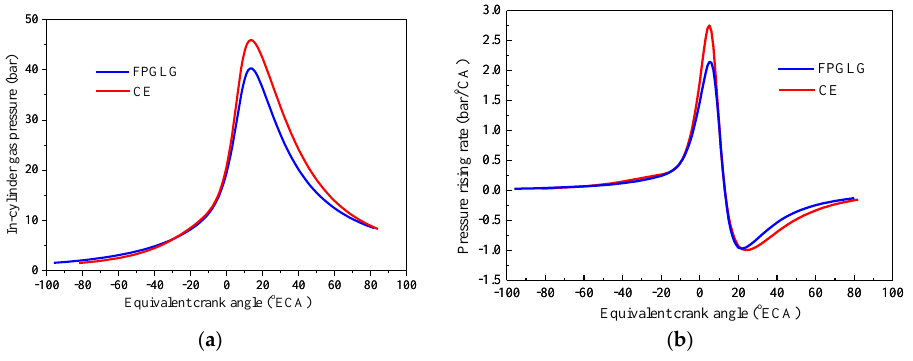
Figure 13. ( a ) Comparison of the in-cylinder gas pressure; ( b ) comparison of the in-cylinder gas pressure rising rate.